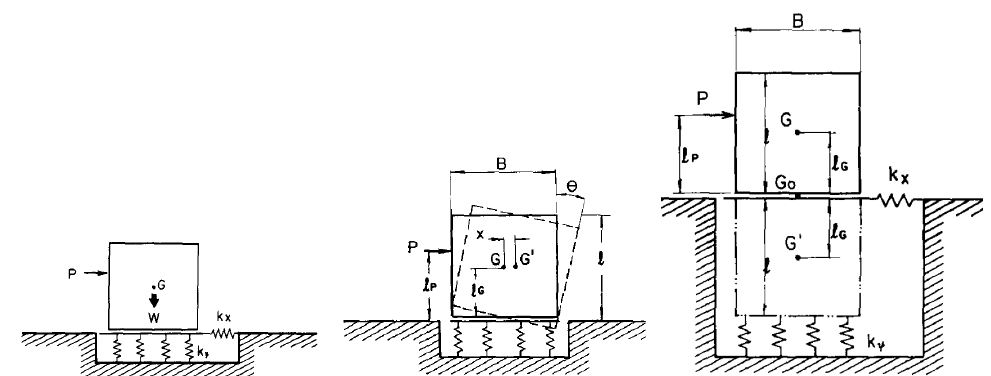
Figure 5. A selection of N-Degree Of Freedom (NDOF) models for caisson structures as presented by Goda [26], with permission from Elsevier, 2020. Left : Ito et al. [23]. Middle : Hayashi et al. [22]. Right : Goda